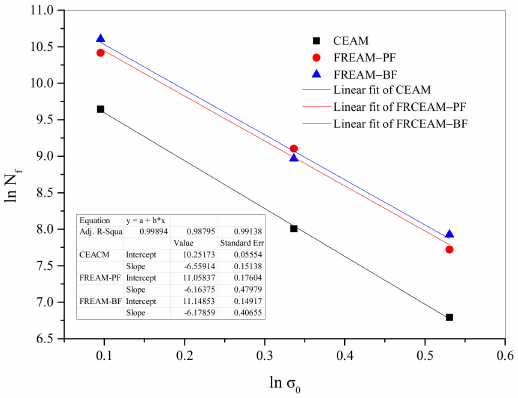
Figure 9. Comparison for fatigue performance of CEAM and